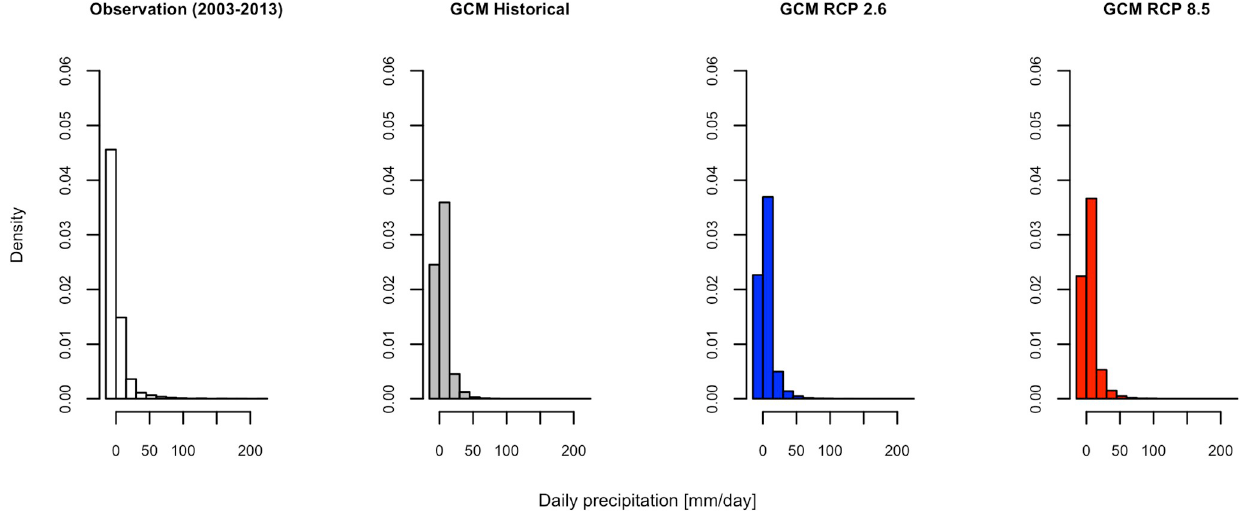
Fig 4. Differences in the precipitation among observed and MIROC (a global climate model) data. The leftmost bar in each histogram represents the frequency of zero precipitation.